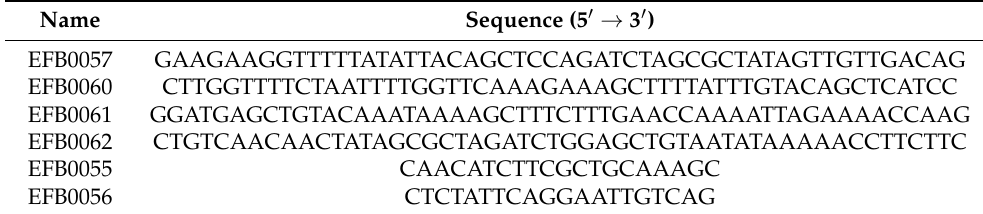
Table 2. Oligonucleotides used in this